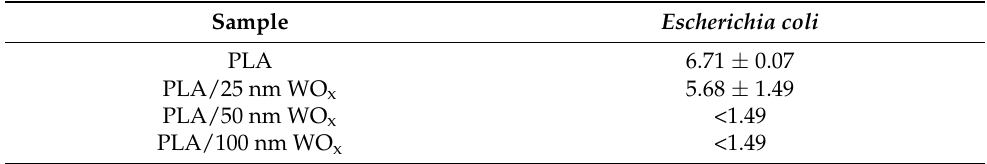
Table 3. Escherichia coli viability expressed as log 10 CFU cm − 2 (mean values ± standard error) after 24 h contact with PLA and WO x -coated